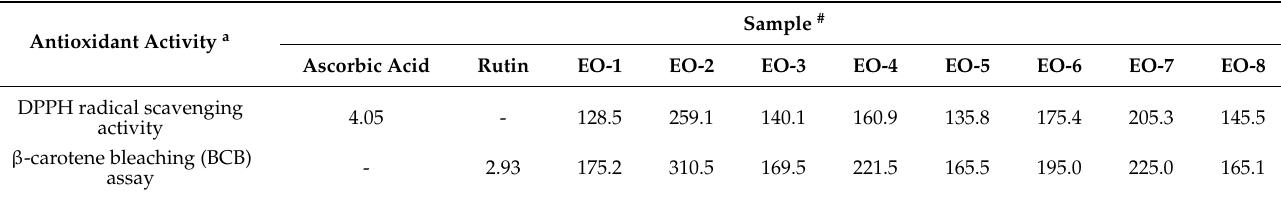
Table 1. DPPH radical scavenging activity and β -carotene bleaching (BCB) inhibition activity of R. coriaria L. essential oil (Sumac EOs 1–8) from the Jordanian market and agricultural field.